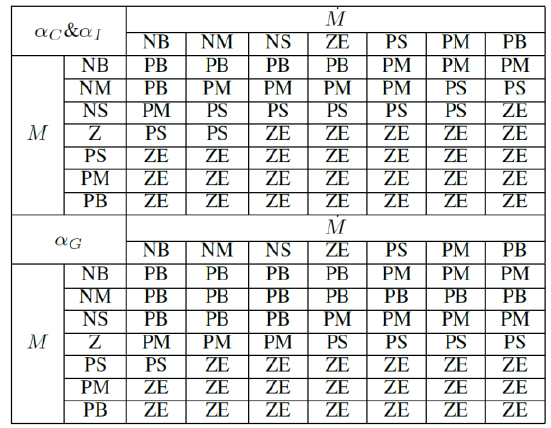
Figure 12. Fuzzy rules of assistant